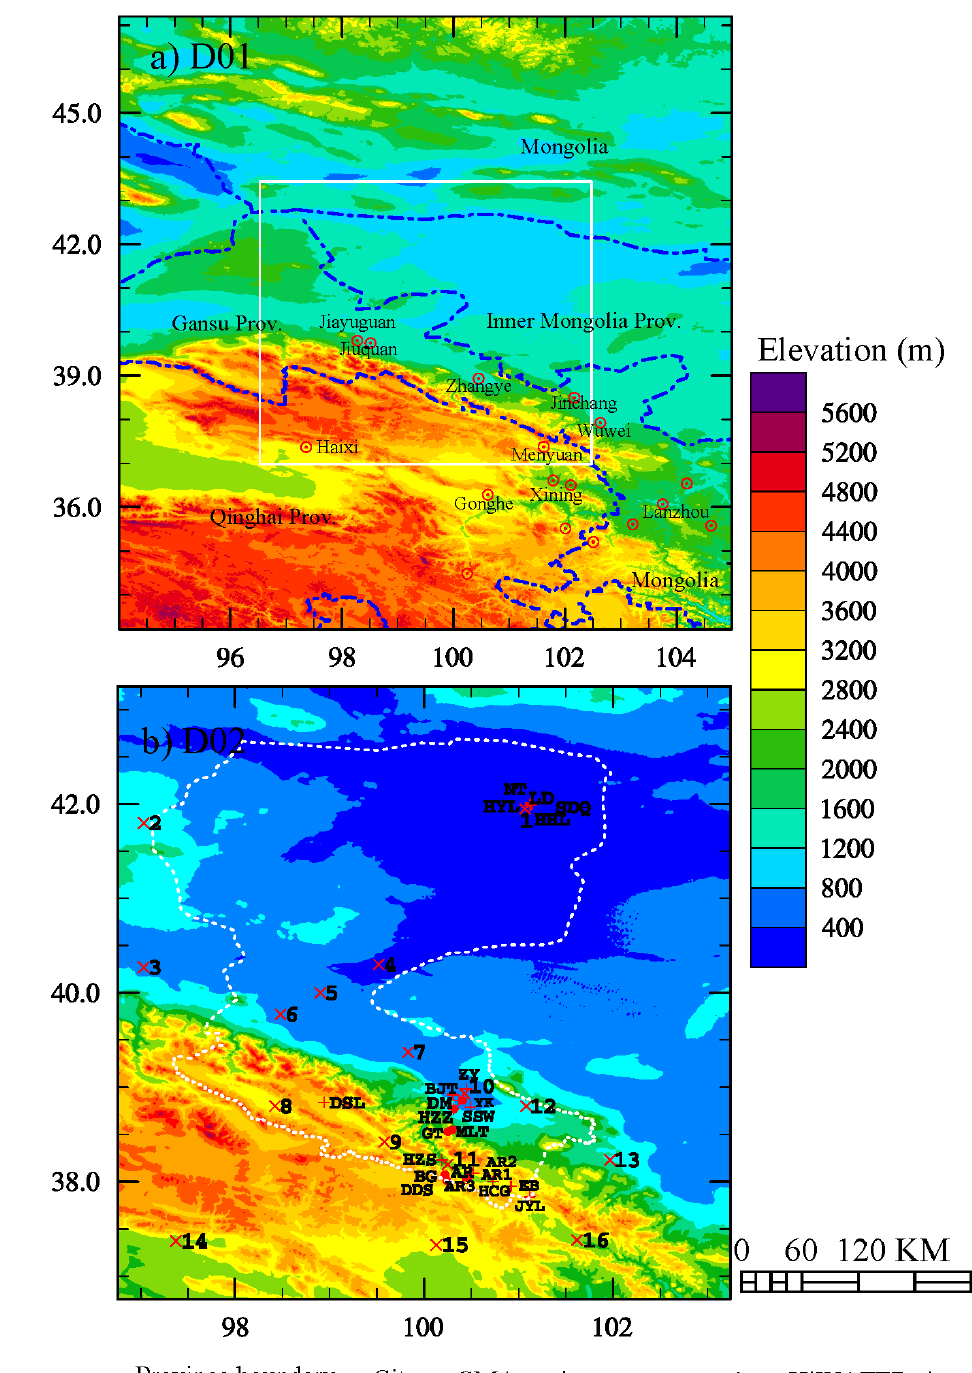
Figure 1. Nesting domain configuration for the numerical experiment ( a ) for the first domain; ( b ) for the second domain (a red cross is a CMA (Chinese Meteorological Administration) station, with the numbers 1–16 being 1 Ejin, 2 Mazongshan, 3 Yumen, 4 Dingxin, 5